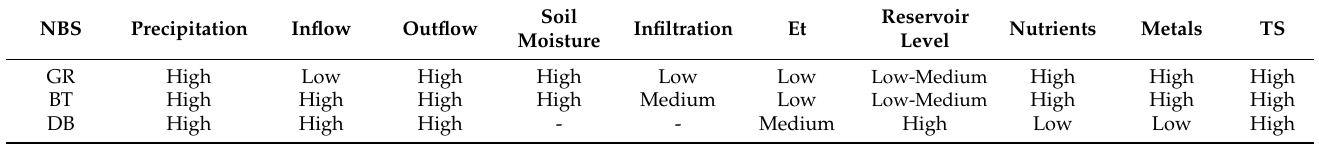
The main parameters of the evaluated techniques were considered. The ratings represented by “-” mean that monitoring does not apply to the technique in its usual design. NBS: Nature-based Solutions; GR: green roof; BT: bioretention; DB: detention basins; ET: